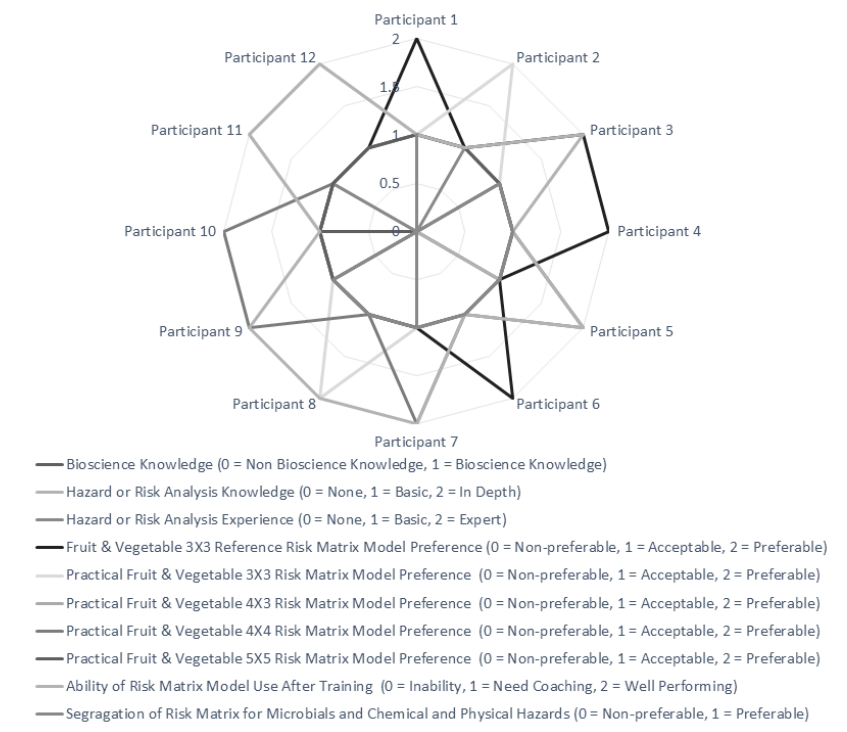
Figure 5. Fruit and vegetable food safety risk map plotting matrices’ preference test.